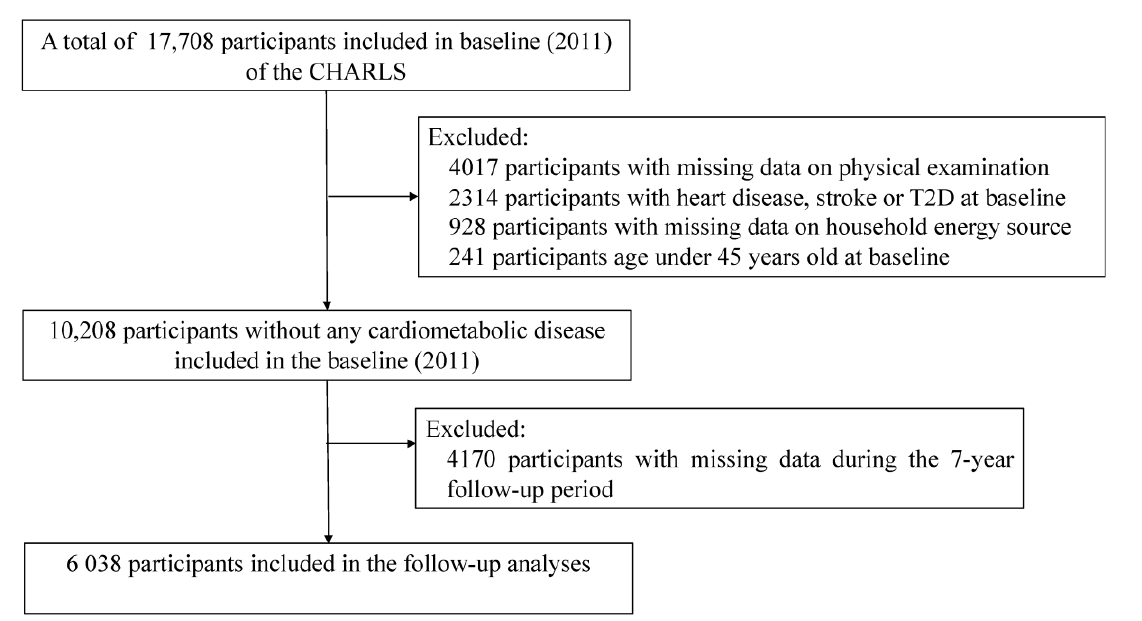
Figure 1. Flow chart of the selection process of